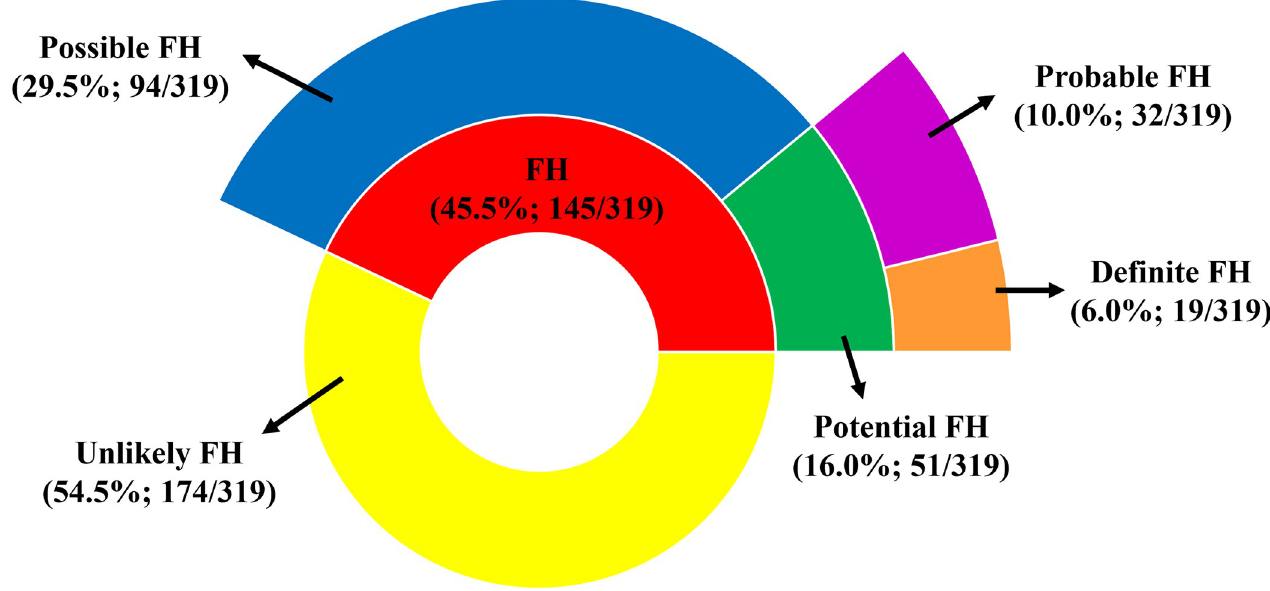
Fig 1. Prevalence of FH among AP-PCAD individuals (n = 319) based on Dutch Lipid Clinic Network Criteria.